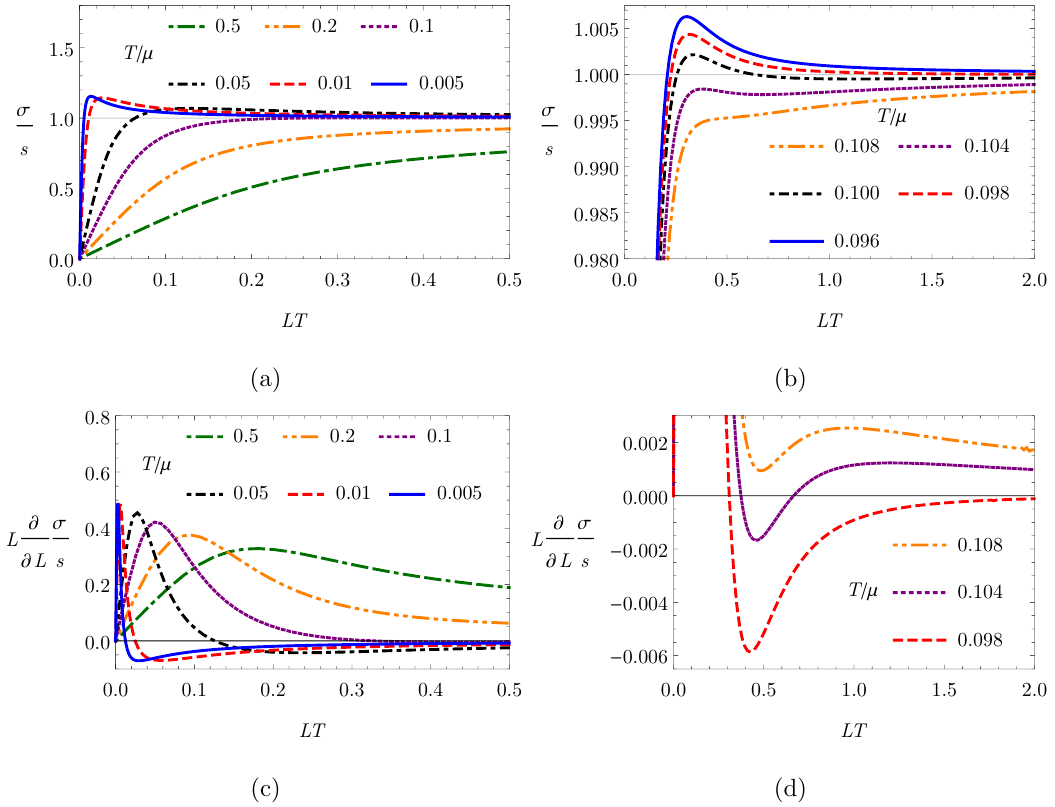
Figure 9. (a) The ED, (cid:27) , in units of entropy density s , versus LT for the strip in AdS-RN with d = 4, showing the formation of a global maximum as T=(cid:22) decreases from T=(cid:22) = 0 : 5 down to 0 : 005. (b) Close-up of (a), showing the formation of a local minimum and maximum before the formation of the global maximum, as T=(cid:22) decreases from T=(cid:22) = 0 : 108 down to 0 : 096. (c) Logarithmic derivative L @ of (a). (d) Close-up of (c) showing the logarithmic derivative for T=(cid:22) = 0 : 108, which has no @L zero, indicating (cid:27)=s is monotonic in LT , then T=(cid:22) = 0 : 104, which has two zeroes, indicating a local minimum and maximum in (cid:27)=s , and (cid:12)nally T=(cid:22) = 0 : 098, which has a single zero, indicating a global maximum in (cid:27)=s